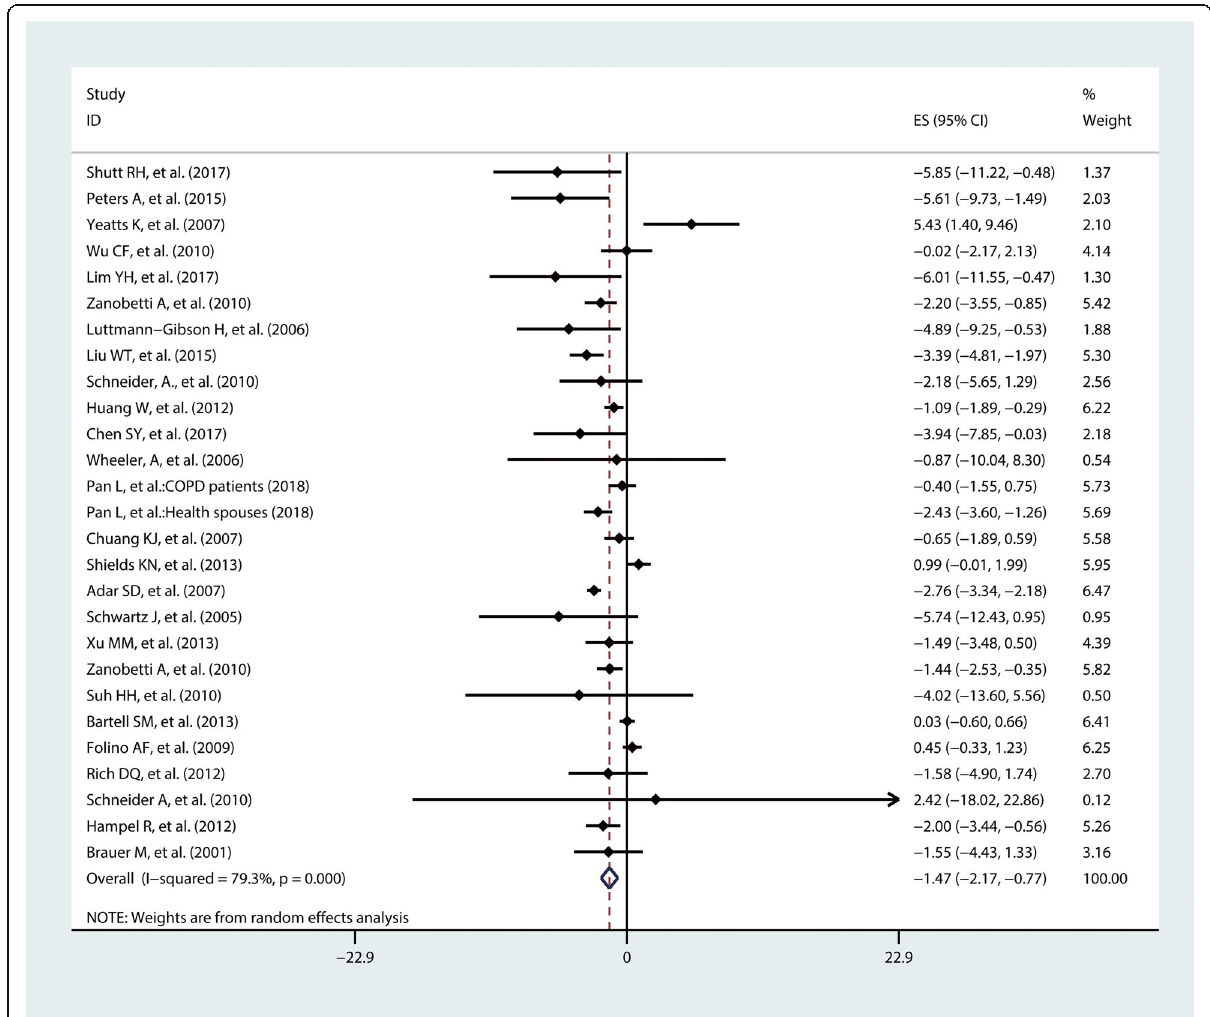
Fig. 3 Pooled percent change (%) of rMSSD associated with a 10 μ g/m 3 increase of PM